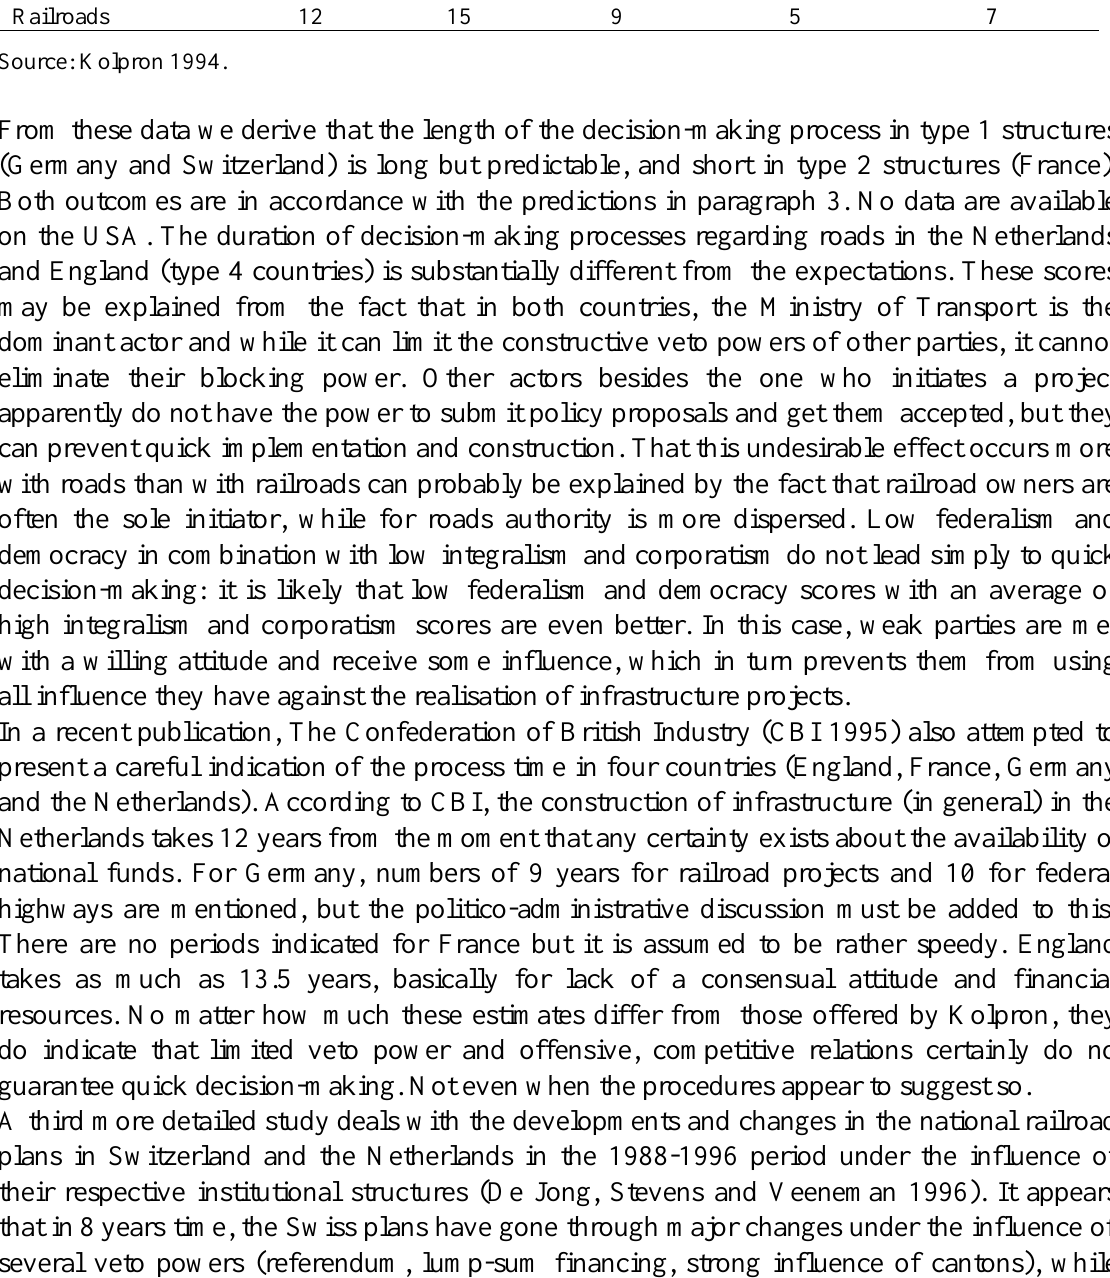
Table 4. Duration of the decision-making process in years (measured until 1990) Transport mode Roads 16 16 Railroads 12 15 5